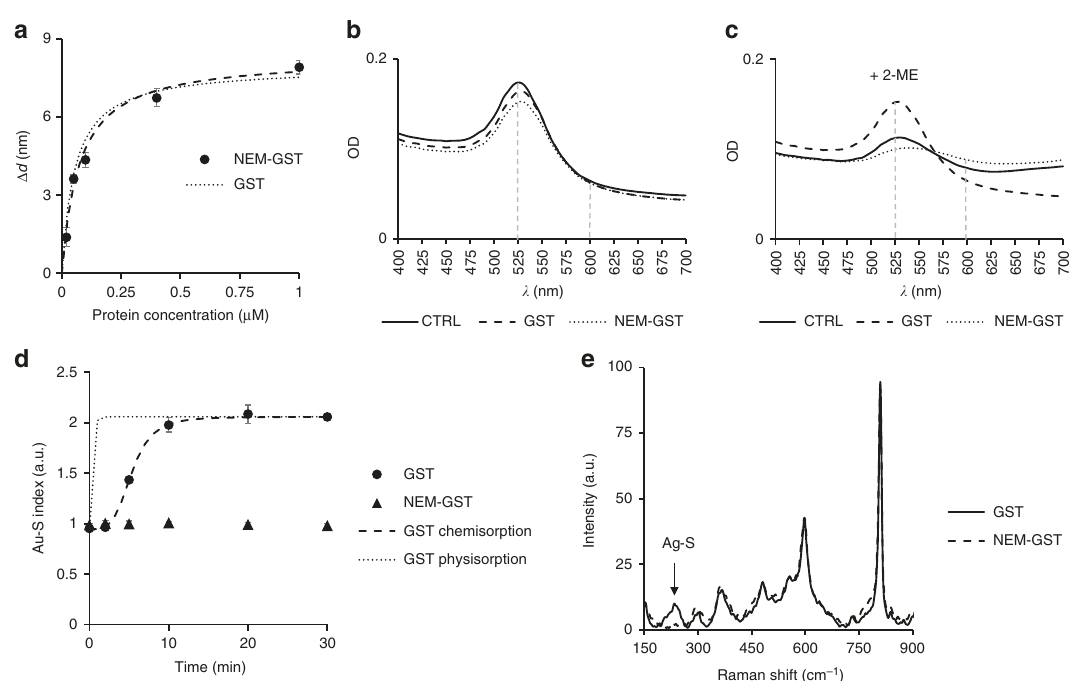
Fig. 2 The role of GST thiols in the binding to GNPs. a Equilibrium binding data of NEM-GST fi tted to the binding model (dashed line) show no signi fi cant difference with those of GST (dotted line, obtained from Fig. 1b; 95% con fi dence intervals for K D and Δ d MAX estimates are represented in Supplementary Figure 3). b UV – vis spectra of naked GNPs (CTRL) compared to GNPs coated with GST or NEM-GST. Vertical dashed lines indicate the two wavelengths, 525 and 600 nm, that have been used for calculation of the Au – S index. c UV – vis spectra of the same colloids in b but after treatment with 2-ME. d Au – S stability index measured at different times shows an increased stability of GST/GNPs over time, whereas NEM-GST failed to protect from aggregation at any time point. GST chemisorption is represented as the fi t of the Au – S index data to a sigmoid (dashed line). This is compared to the calculated physisorption trend (dotted line), obtained from Eq. 1 for the same GST concentration used in the chemisorption experiment. e SERS spectra of GST and NEM-GST adsorbed on silver colloid. The black arrow indicates the peak at 233 cm − 1 due to Ag – S mediated chemisorption. All data points with error bars in the fi gure represent average and standard deviation of three